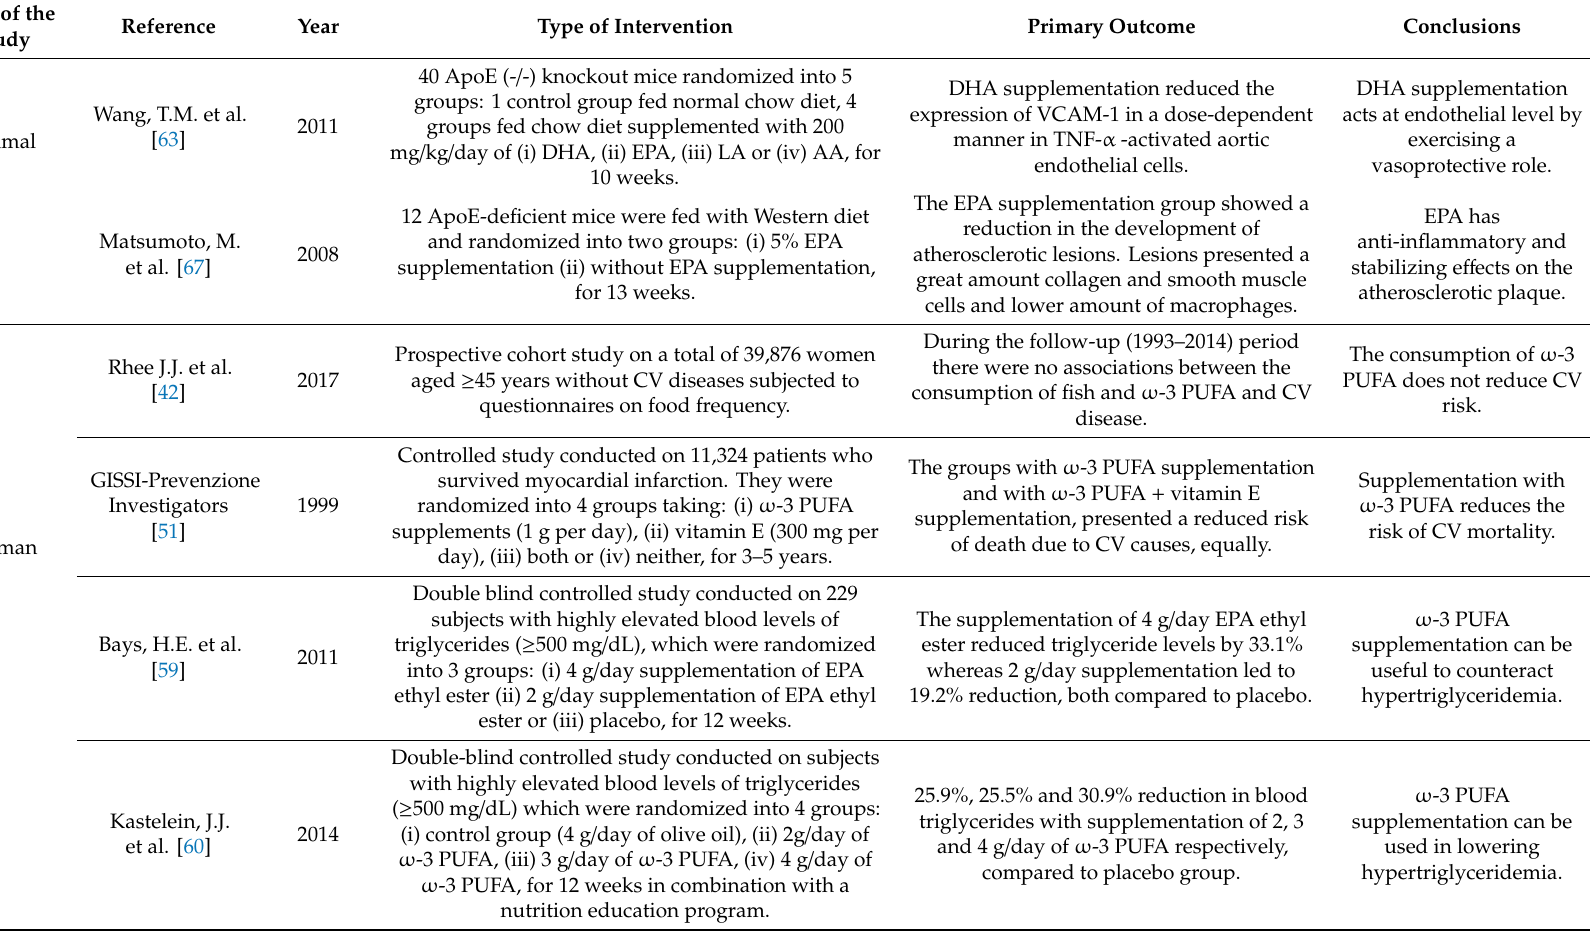
Table 3. Studies on polyunsaturated fatty acids (PUFAs) and cardiovascular